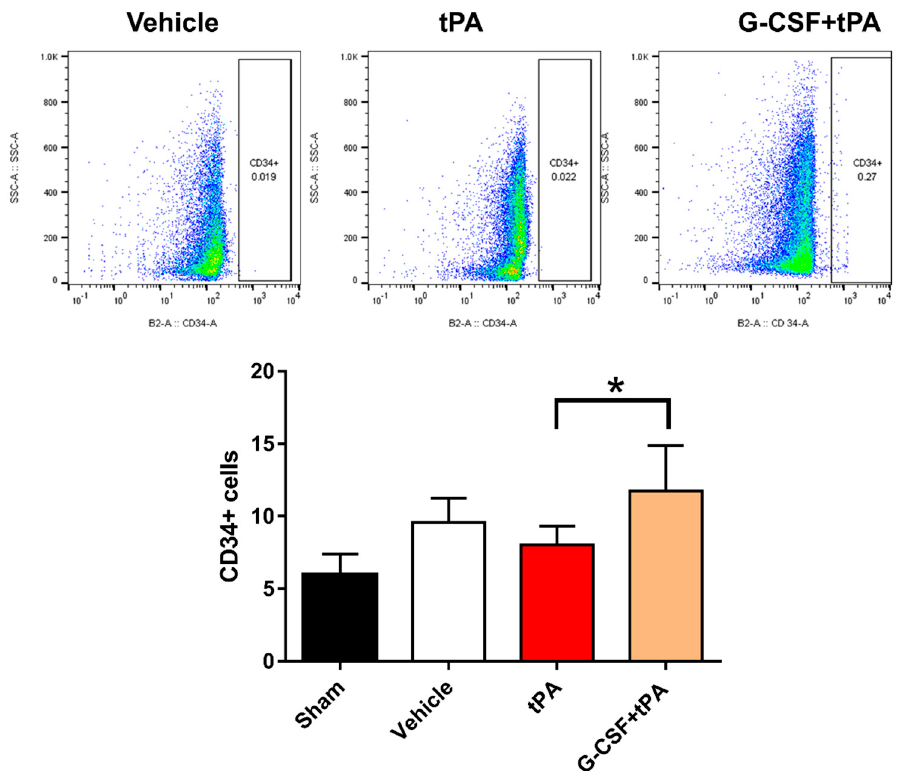
Figure 4. Mobilization of CD34+ cells in the peripheral blood by G-CSF. Top panel: Representative flow cytometry measurements of the number of CD34+ cells in the peripheral blood of vehicle-, tPA-, and G-CSF+tPA-treated stroked rats obtained 3 days after stroke. Isotype-matched antibodies were used as a control. Bottom: Quantitative analysis of the number of circulating CD34+ cells 3 days after stroke. G-CSF treatment significantly increased the number of CD34+ cells in the peripheral blood. The number of CD34+ cells in animals which did not undergo stroke surgery (sham) is also shown; * p < 0.05, n = 7–8 rats per group. The data are expressed as mean ± S.E.M.